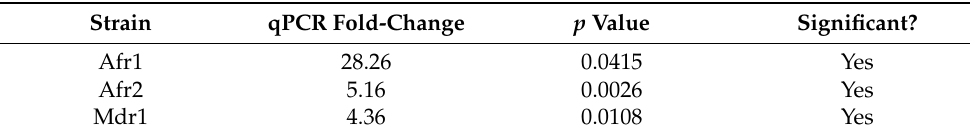
Table 2. Efflux Pumps Expression in 10-generation